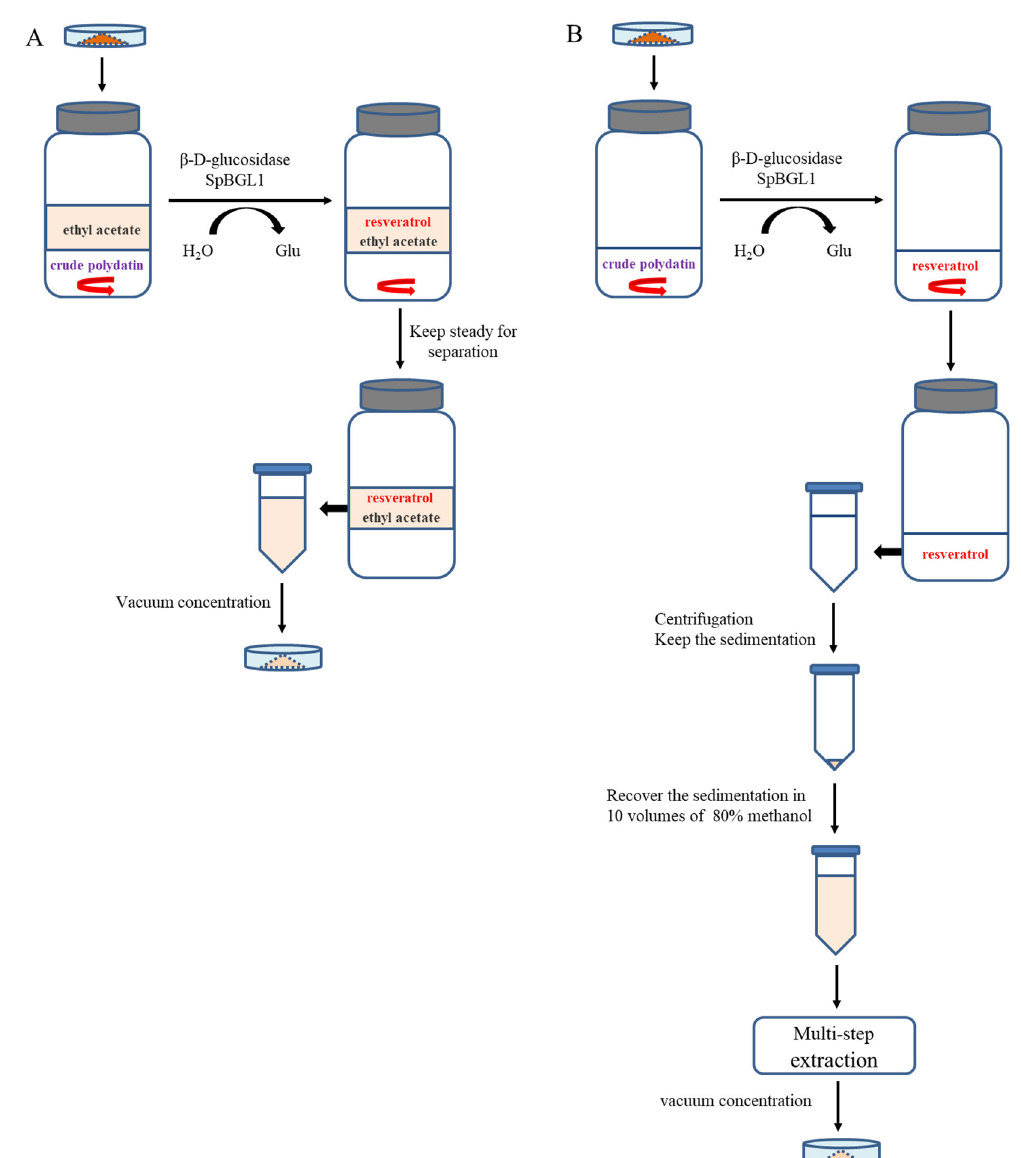
Figure 7. Schematic presentation of the biphase ( A ) and uniphase ( B ) conversion systems set up in this study and the major procedure of using these systems to convert polydatin into resveratrol. In the biphase system, the conversion took place in the aqueous phase, and the resulting resveratrol continuously dissolved in the organic phase. Resveratrol can be extracted directly from the organic phase by vacuum concentration. In the uniphase conversion system, because of the low solubility of resveratrol in aqueous solution, the product must first be separated from the aqueous solution by centrifugation, then recovered in 80% ethanol. This solution is then passed through an overnight multistep extraction procedure before finally being vacuum concentrated.